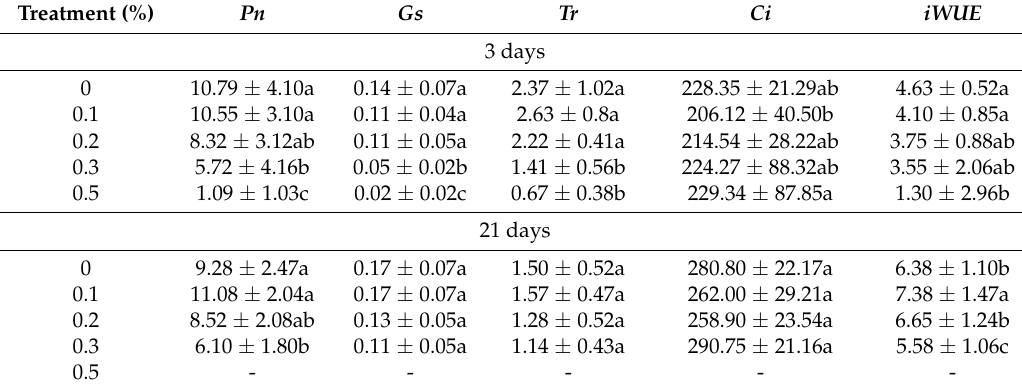
Table 2. Effect of increasing soil salinity levels on the net assimilation rate ( Pn , µ mol m − 2 s − 1 ), stomatal